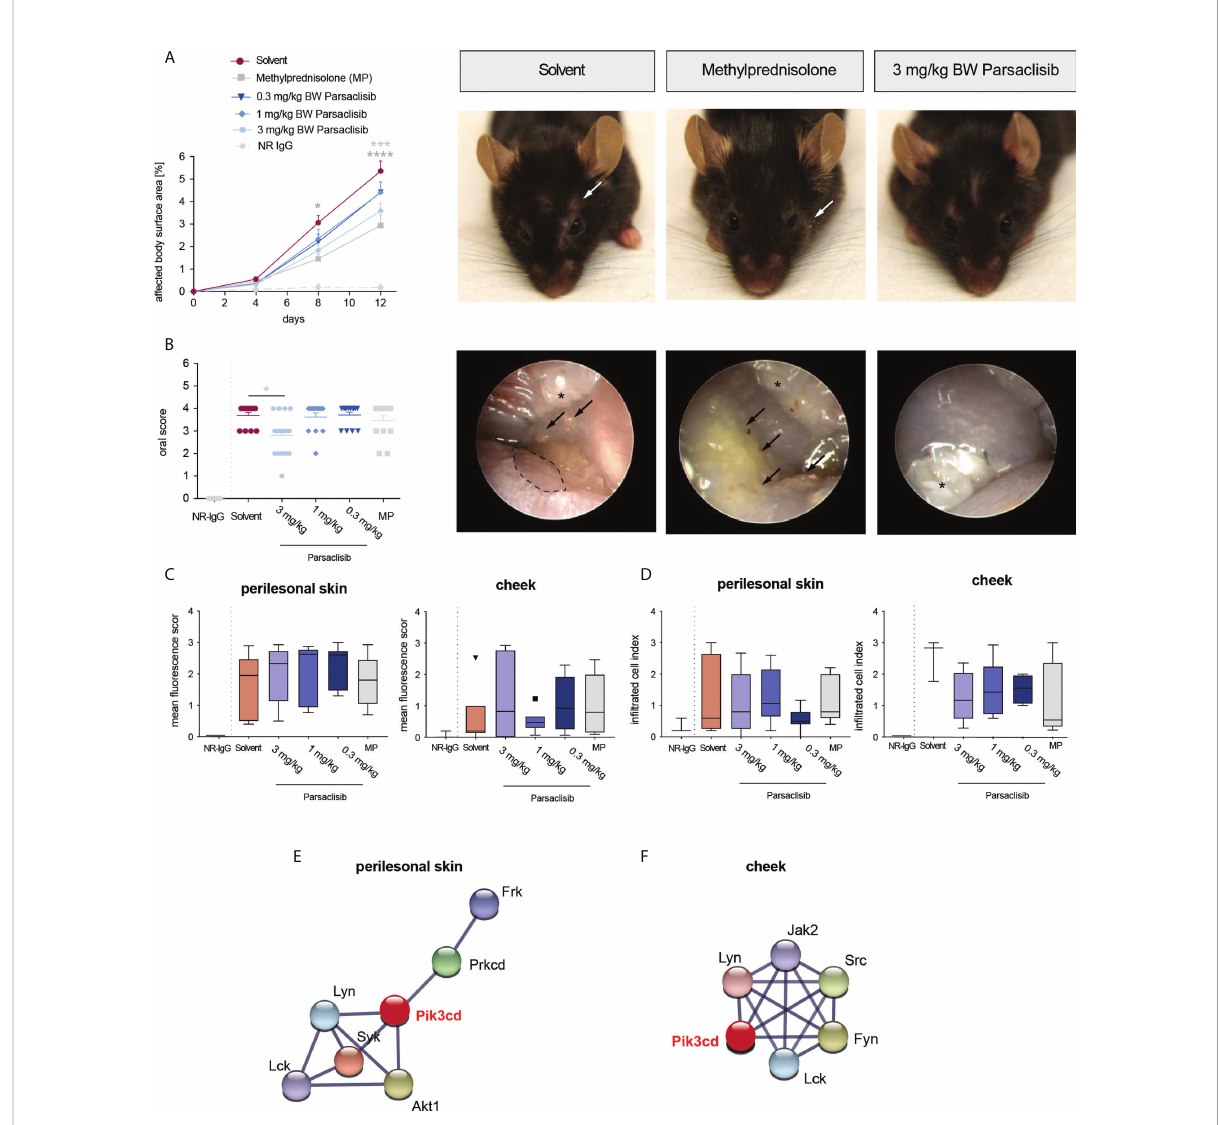
FIGURE 4 Parsaclisib improves the clinical outcome in antibody transfer-induced MMP. C57BL/6J mice were injected every other day with 6 mg of rabbit anti-mLAM a 3 IgG (n=15/group) or normal rabbit (NR) IgG (n=6) for a total of 12 days. Administration of MP, solvent or parsaclisib (0.3, 1, or 3 mg/kg) was initiated on day 0 of the experiment and continued until day 11. (A) Percentage of affected body surface area was determined at days, 0, 4, 8 and 12. Representative clinical images of the mice at day 12. Data are shown as mean ± SD (B) High-resolution endoscopy of mouth oral cavity (i.e., pharyngeal mucosa, tongue, and right/left buccal) was conducted to determine the extent of oral lesions at day 12. Data are shown as scatter blot, including mean ± SEM. Representative pictures of oral cavity. Arrows indicate mucosal lesions, asterisks indicate teeth. PamGene kinome analysis of lesional skin treated with solvent vs. 3 mg/ml parsaclisib (n=3). (C) The mean fl uorescence intensity of IgG binding to the dermal-epidermal junction was analyzed in ears or cheek (oral mucosa), respectively at the fi nal end point. (D) The cumulative histological score index (amount of skin in fi ltration, epidermal thickening and split formation at the DEJ) of ears, or mucosa was analyzed at day 12. (C, D) Data are shown as Tukey ’ s box-and-whisker plots. ANOVA on ranks (Kruskal-Wallis) was applied followed by a Dunn´s multiple comparison test. String database analysis of kinases that are modulated by parsaclisib in (E) perilesional skin and (F) mucosa; contrasting kinase activation from solvent- to parsaclisib-treated mice. STING interaction modules are shown at the medium con fi dence level. Thickness of the lines indicates the strength of the predicted interaction. Colors of kinases are randomly selected. Differently activated kinases that did not have any connections to other kinases were excluded from the networks. *p<0.05, ***p<0.001,